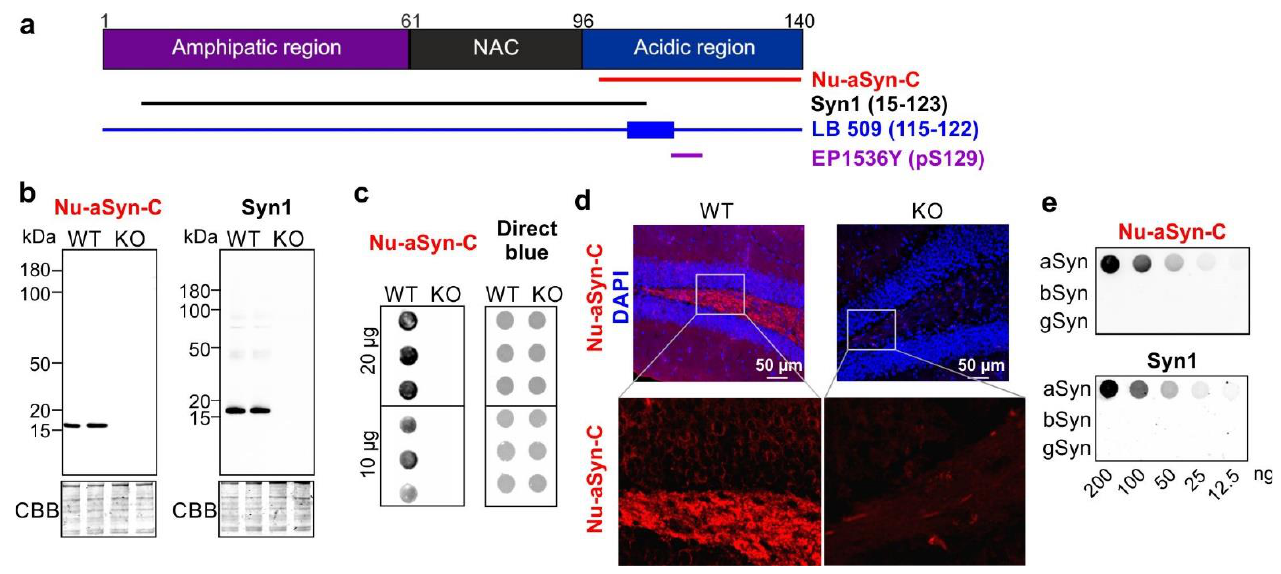
Figure 1. Nu-aSyn-C antibody is specific to aSyn. ( a ) Structure of human aSyn and antibodies against different aSyn epitopes applied in this study. ( b ) Denaturing WB analysis of brain lysates of WT and aSyn KO mice using Nu-aSyn-C and Syn1 antibodies demonstrates specificity of both antibodies to aSyn in WT mice. ( c ) Non-denaturing dot blot analysis of WT and aSyn KO mouse brains reveals immunosignals in WT mice only. An amount of 10 – 20 µg of total protein extract was loaded for WB ( b ) or dot blot ( c ). Loading of the total protein extract was controlled by CBB (WB, ( b )) or using direct blue 71 dye (dot blot, ( c )). ( d ) IHC analysis of WT and KO brain sections using the Nu-aSyn-C antibody shows specific immunosignals in WT brains only (example images from the hippocampus in d; example images from the cortex in Figure S1. ( e ) Dot blot analysis of human recombinant a-, b-, and gSyn using Nu-aSyn-C and Syn1 antibodies. Both antibodies do not cross-react with b- and gSyn.